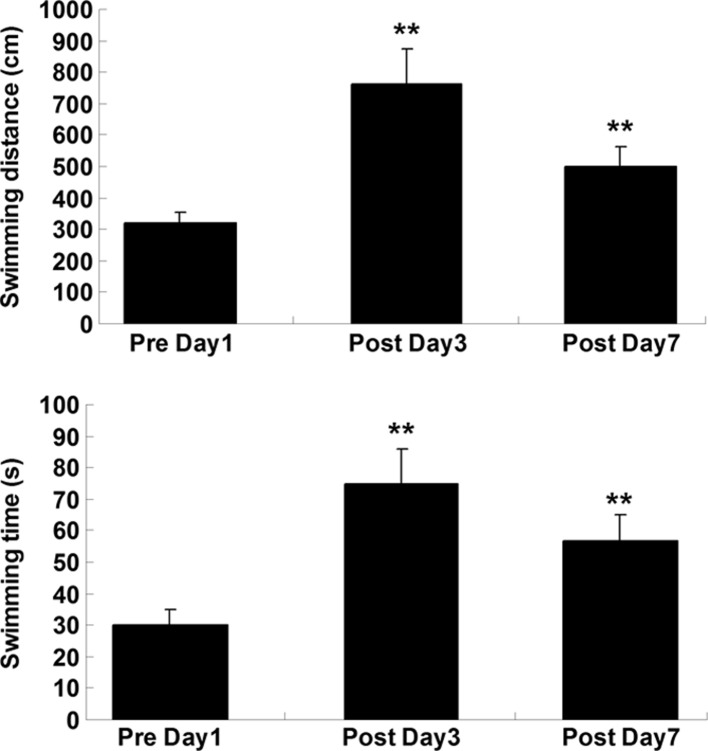
Swimming distance and time of aged rats in the Morris water maze. Results presented are the mean ± standard deviation. Pre Day1, the Morris water maze test was performed one day prior to surgery; Post Day3, the Morris water maze test was performed on the third day after surgery; Post Day7, the Morris water maze test was performed on the seventh day after surgery. **P<0.01 vs. Pre Day1.